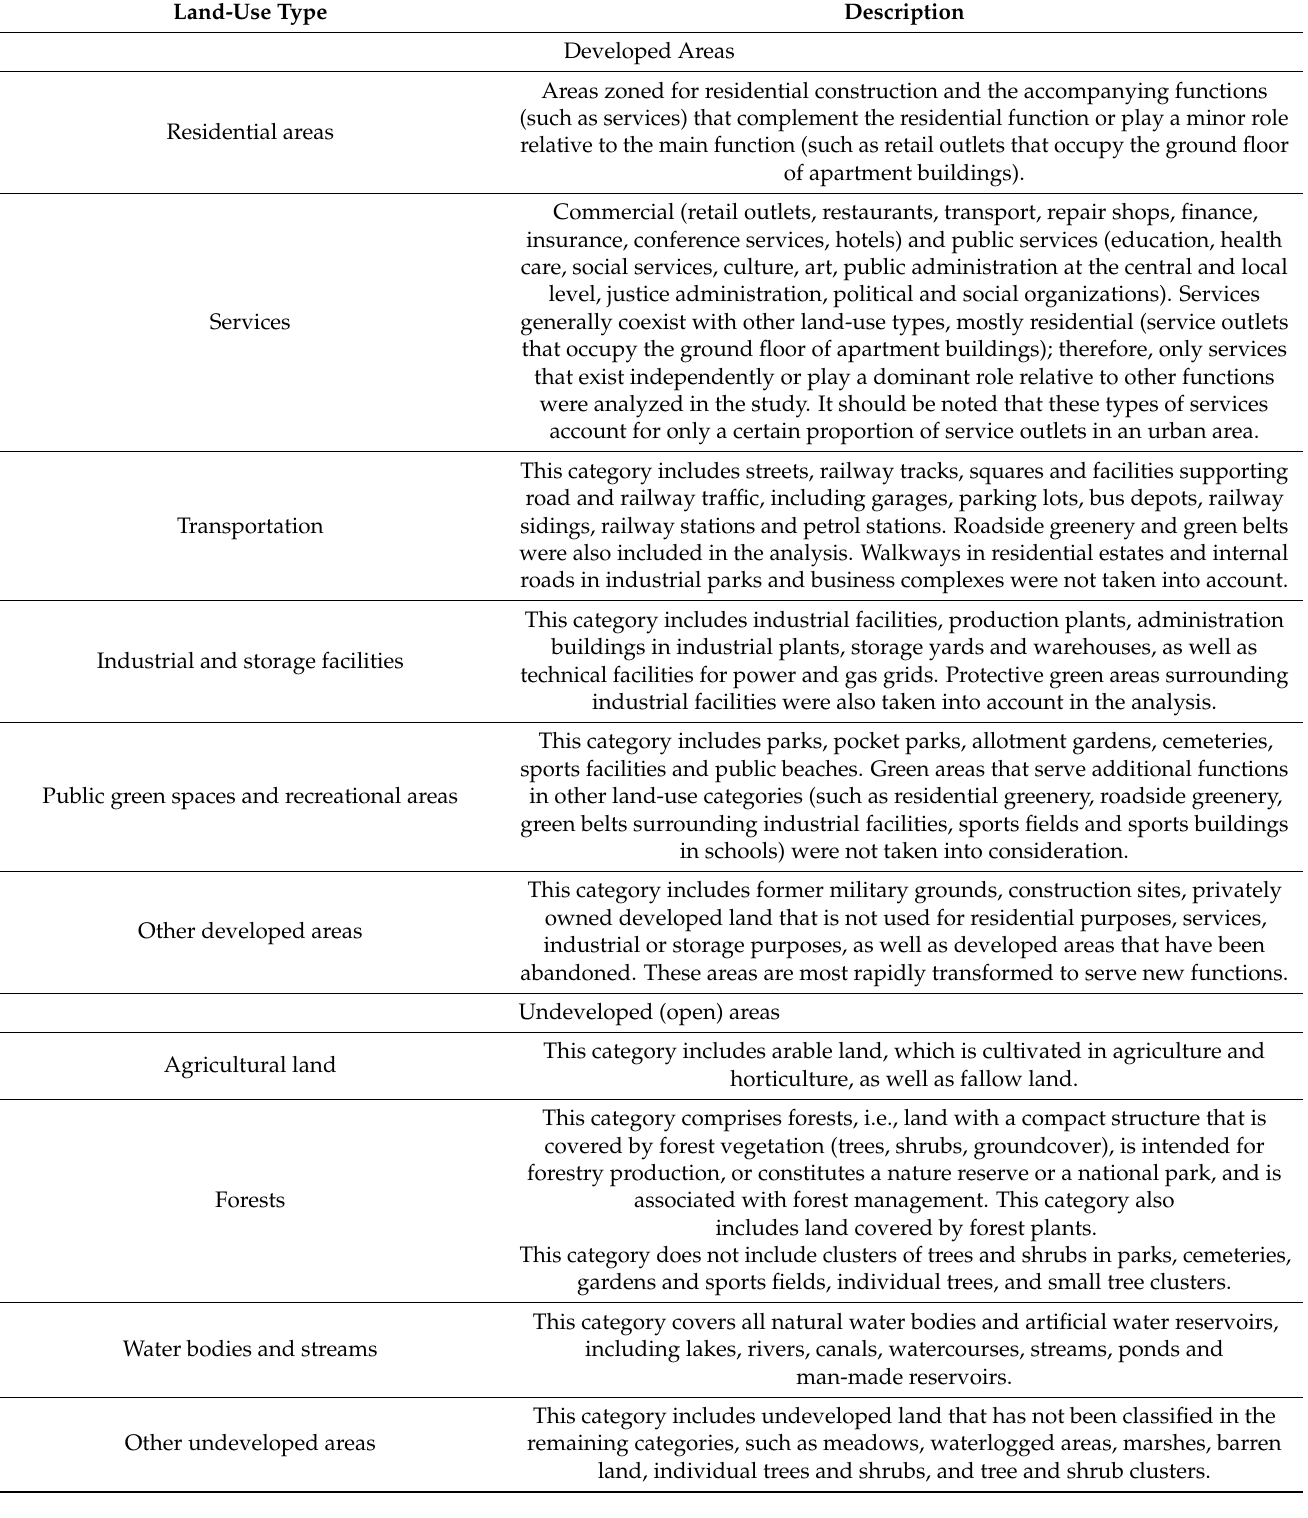
Table 1. Criteria for classifying land-use types in urban